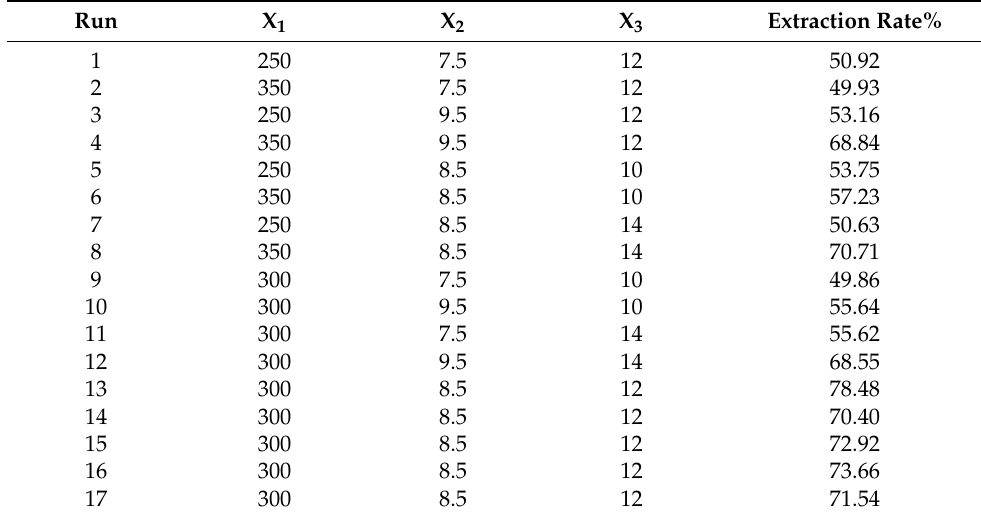
Table 2. Response surface test design and WBY protein extraction rate.